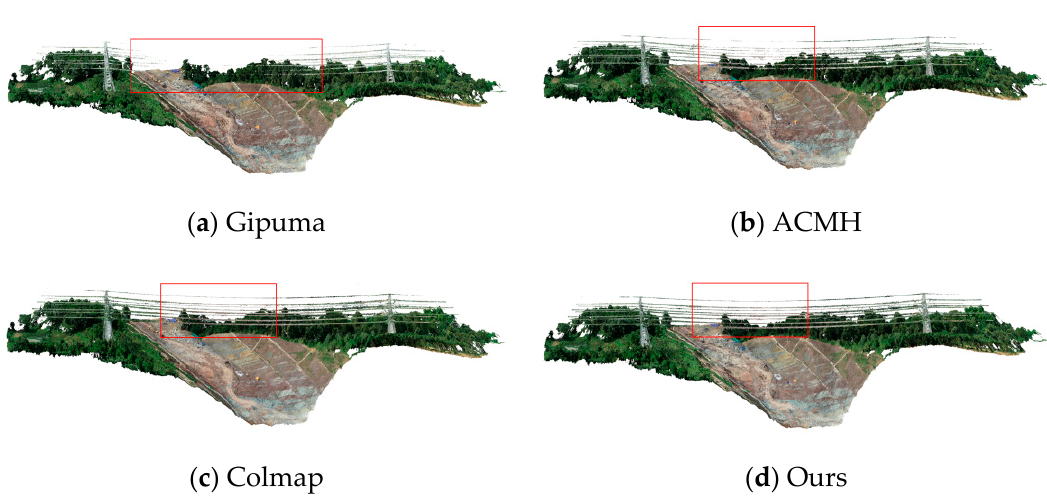
Figure 8. The comparison of reconstructed point clouds of power lines in test site 2. ( a – d ) are generated by Gipuma, ACMH, Colmap, and the proposed method, respectively.